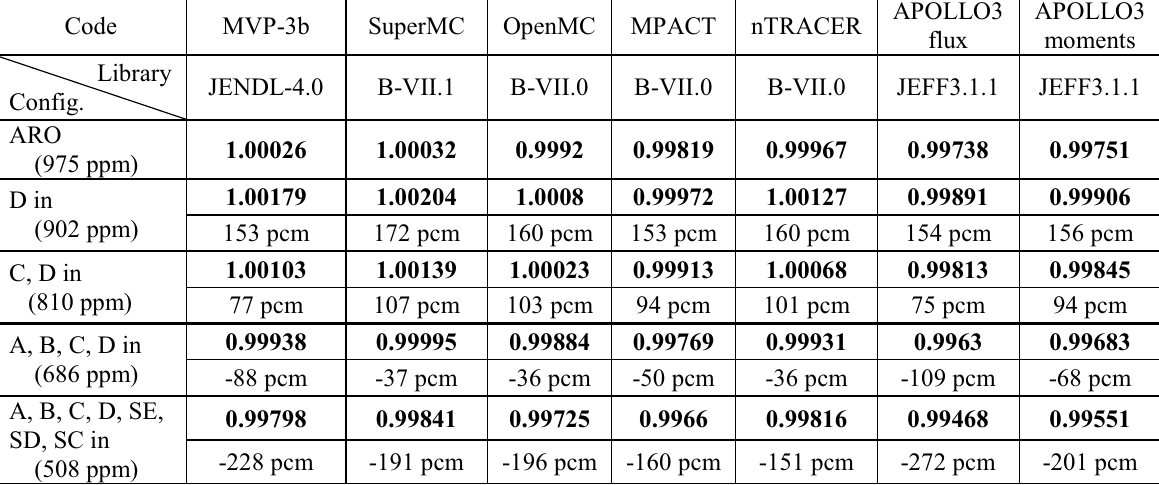
Table III. Keff results for the HZP critical configurations and distances to the ARO